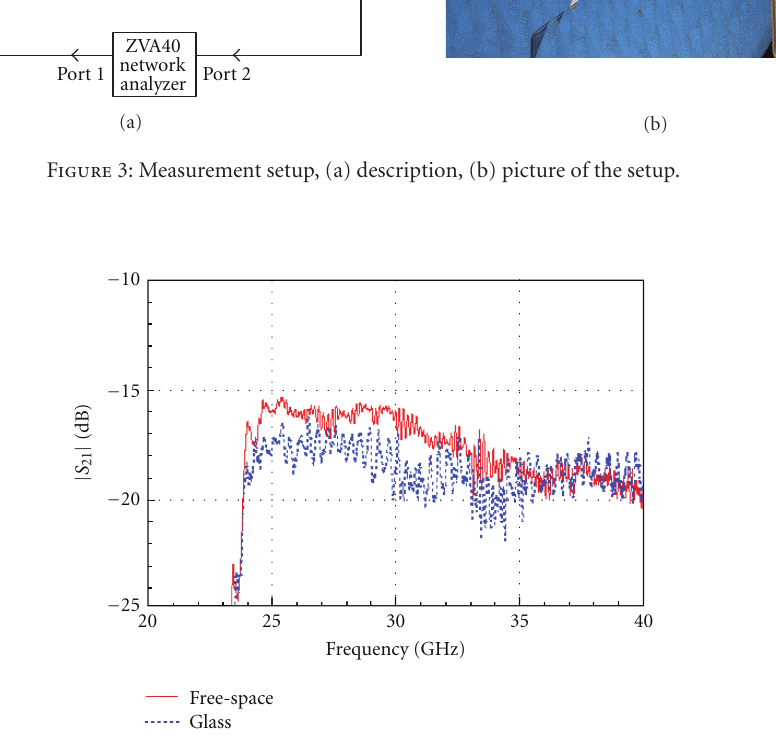
Figure 4: Transmission measurements of free-space and glass-only sample.